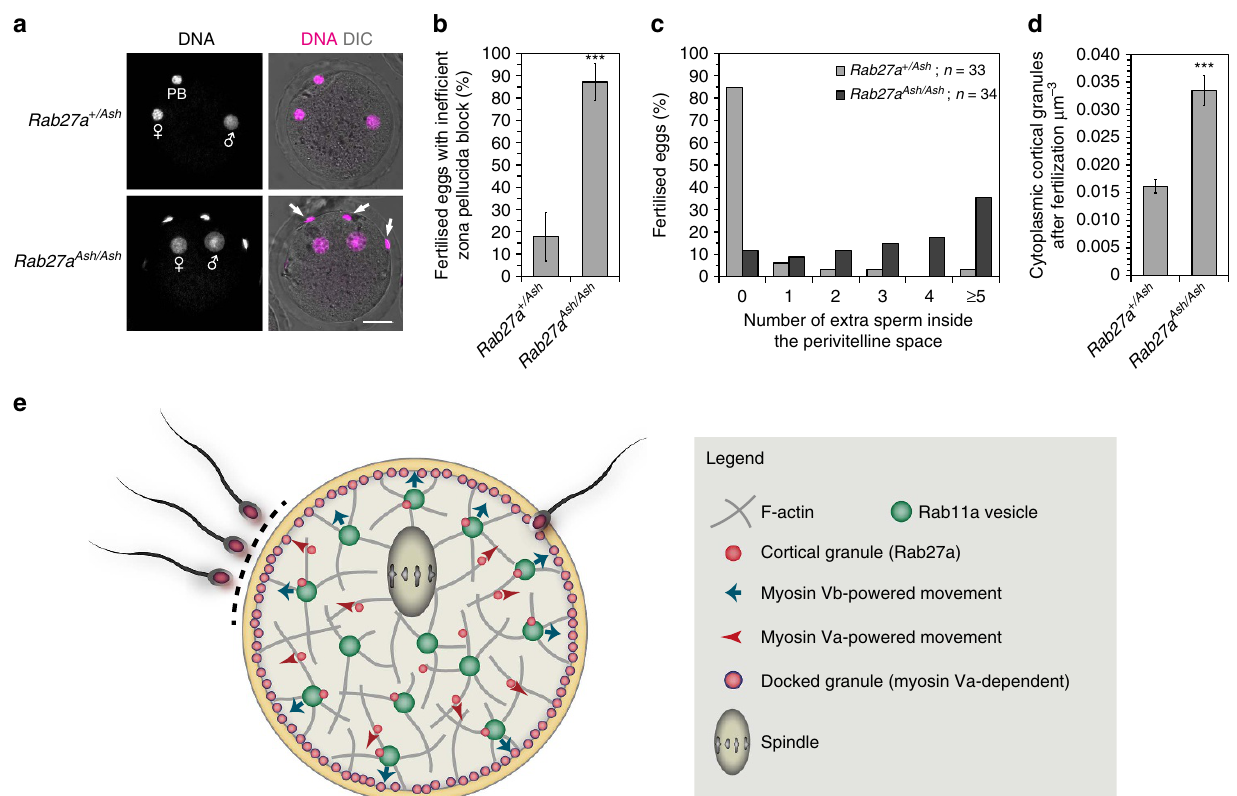
Figure 6 | Disruption of cortical granule translocation severely impairs the zona pellucida block to polyspermy. ( a ) Maximum intensity Z projections of in vitro fertilized oocytes from Rab27a þ /Ash (control) or Rab27a Ash/Ash (mutant) oocytes, fixed and stained with Hoechst. Male and female pronuclei and polar body (PB) are indicated. Note the extra sperm heads present inside the zona pellucida in mutant oocytes (arrows). Scale bar, 20 m m. ( b ) Quantification of the number of fertilized oocytes which had extra sperm heads in the perivitelline space in Rab27a þ /Ash or Rab27a Ash/Ash oocytes (mean ± s.d.; Student’s t test) ( c ) Quantification of the number of extra sperm inside the perivitelline space of fertilized Rab27a þ /Ash or Rab27a Ash/Ash oocytes. ( d ) Quantification of remaining cortical granules in the centre of Rab27a þ /Ash or Rab27a Ash/Ash oocytes after fertilization (mean ± s.d.; Student’s t test). ( e ) Mechanistic model of the two cortical granule translocation mechanisms in mammalian oocytes. See text for details. Significance levels: *** P o 0.001, from three